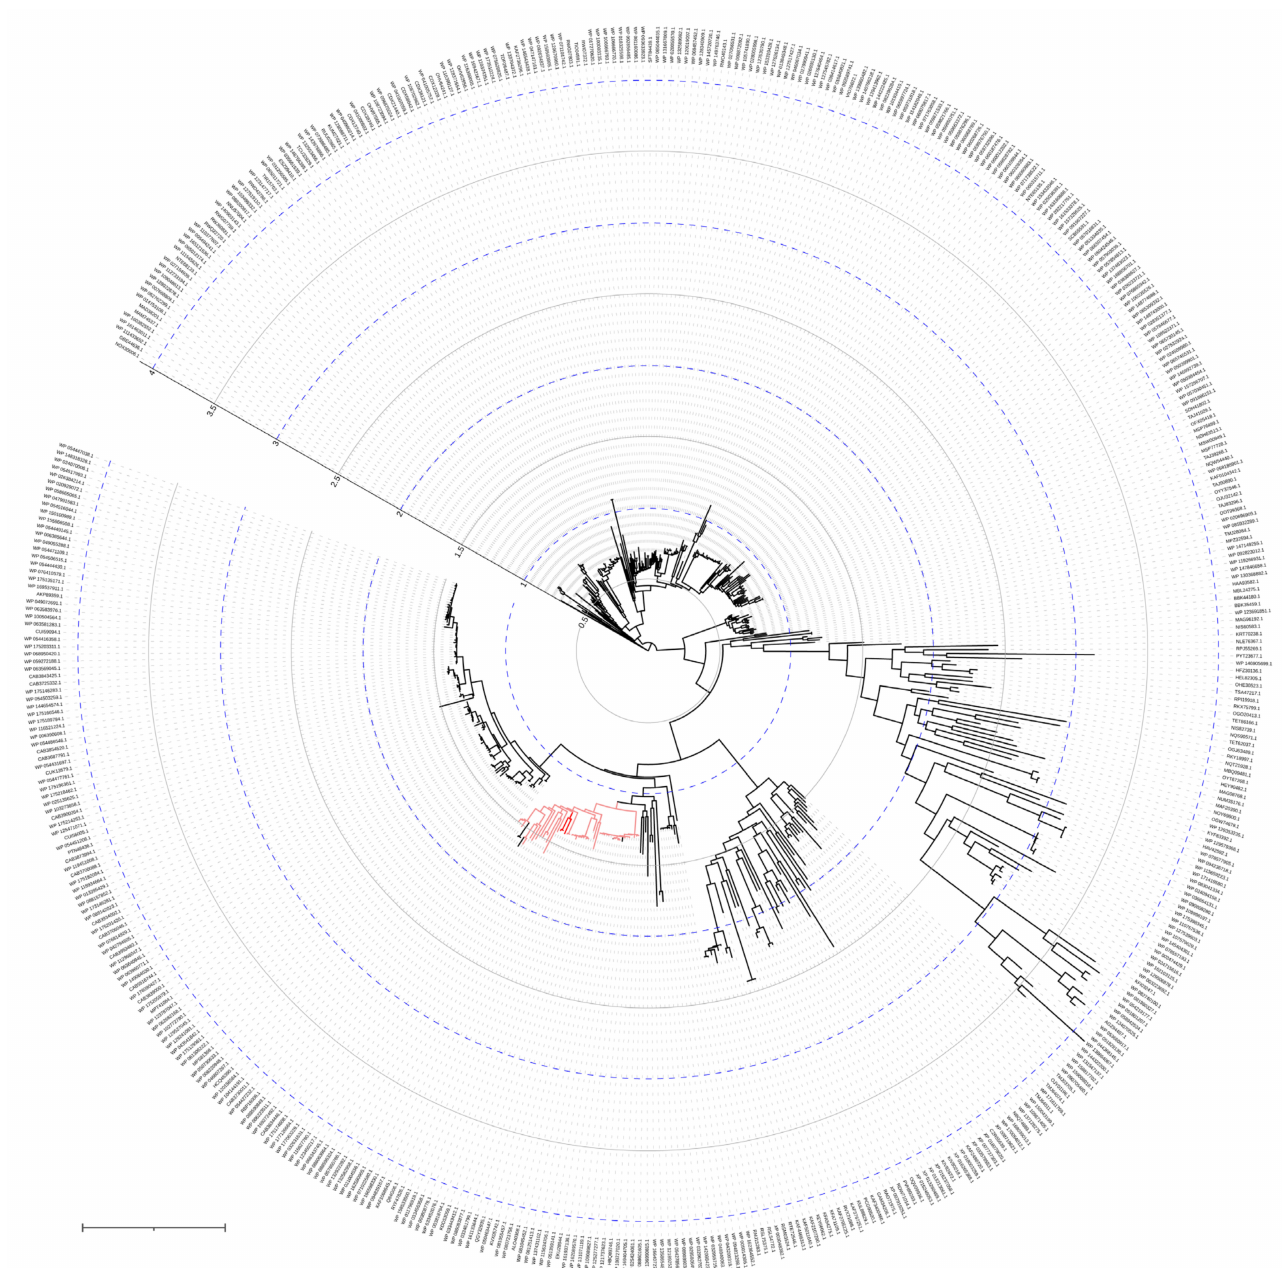
Figure 23. Phylogenetic tree of PPH and its homologous enzymes (down to 45% identity). The tree was built as previously with PDB 2HJP as a reference sequence. Enzymes having high (90–100%) and good (80–89%) identity are highlighted with red and pink,